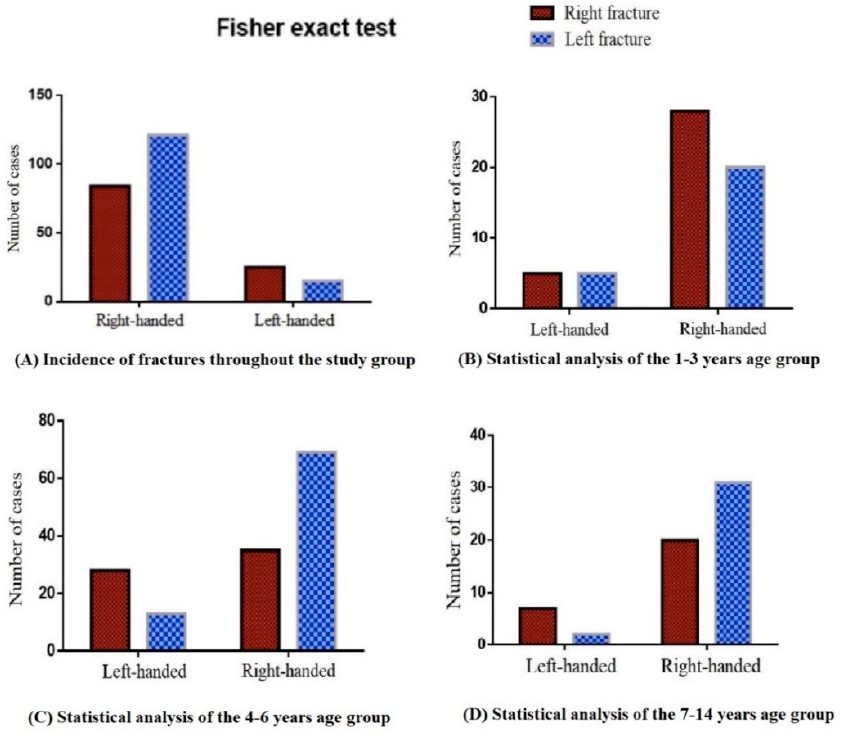
Figure 1. Results of Fischer’s exact test for the entire study group ( A ) and age group 1–3 ( B ), 4–6 ( C ) and 7–14 ( D ).